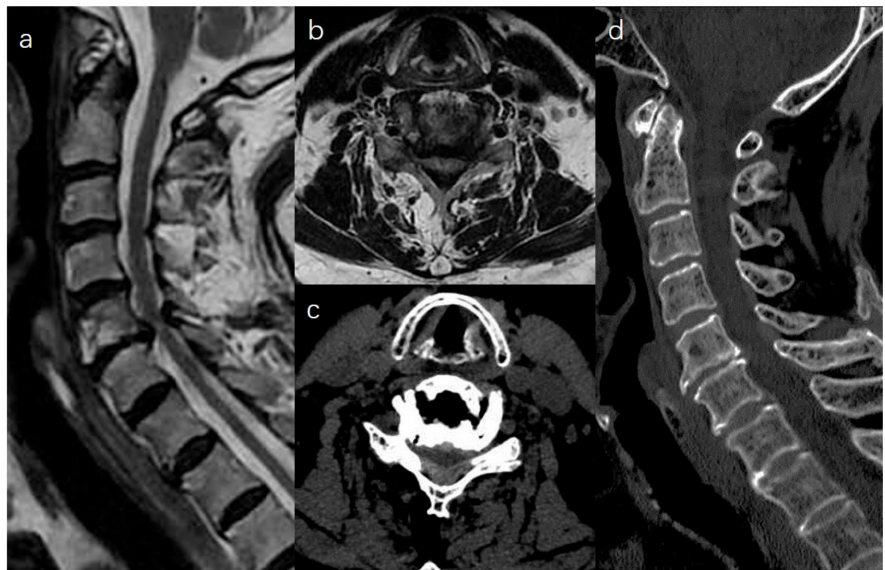
Figure 1. Preoperative MRI showing central canal stenosis at C5–C6 ( a , b ). The spinal cord was compressed by a herniated disc and hypertrophied LF on CT scan ( c , d ). Two horizontal lines were drawn along the C5 and C6 pedicles, and a vertical line was drawn in the midline of the left lateral mass in the anteroposterior view. The junctional point on the left side served as a viewing portal, while the other on the right side served as a working portal (Figure 2a).